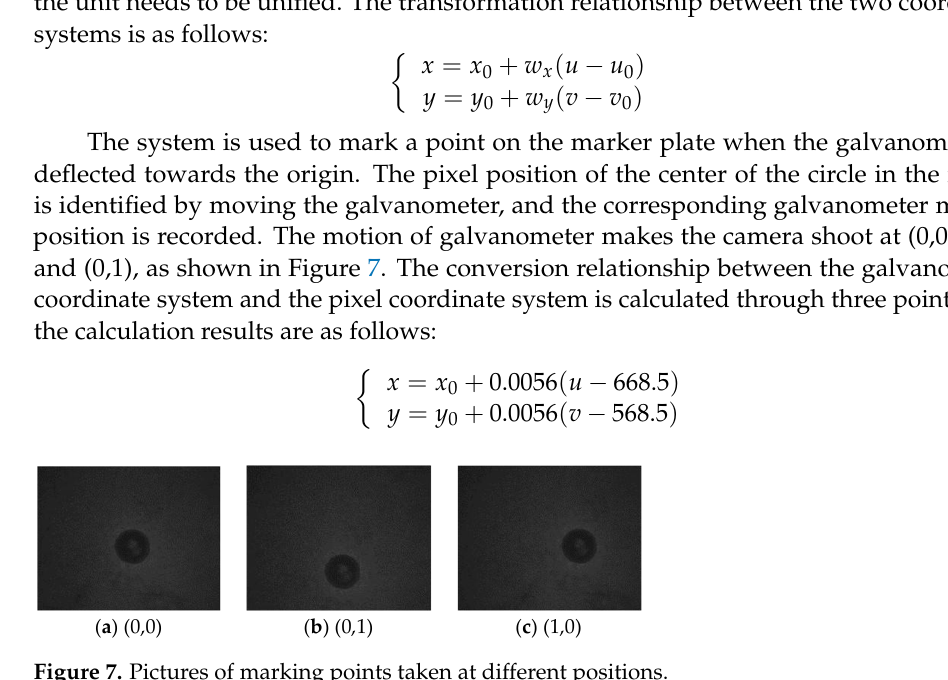
Figure 6. Relationship between the pixel and galvanometer coordinate systems.